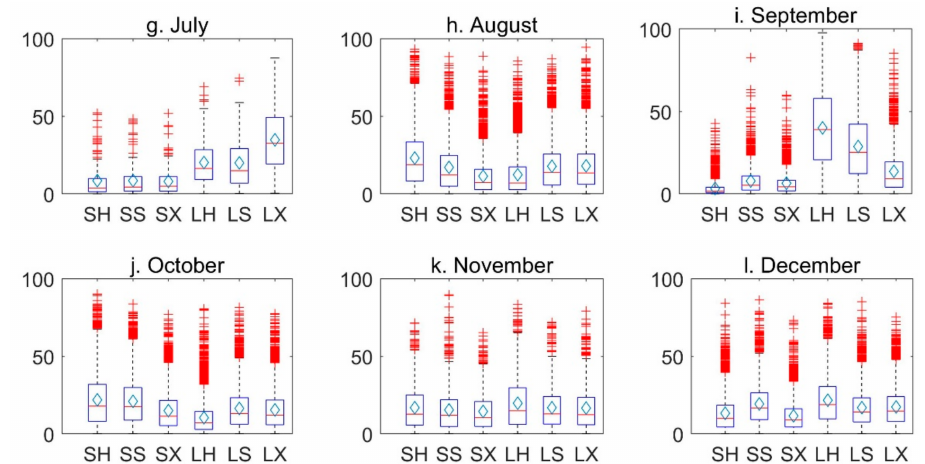
Figure 10. Same as Figure 7 but for maximum monthly runoff.